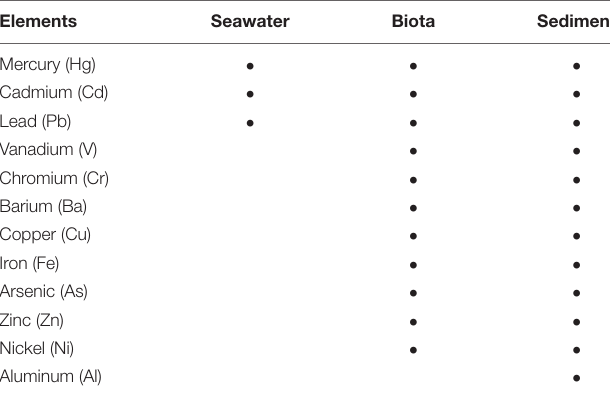
TABLE 1 | Metals considered for comparative analysis of sampling, analytical, and QA/QC procedures in different matrices. Elements